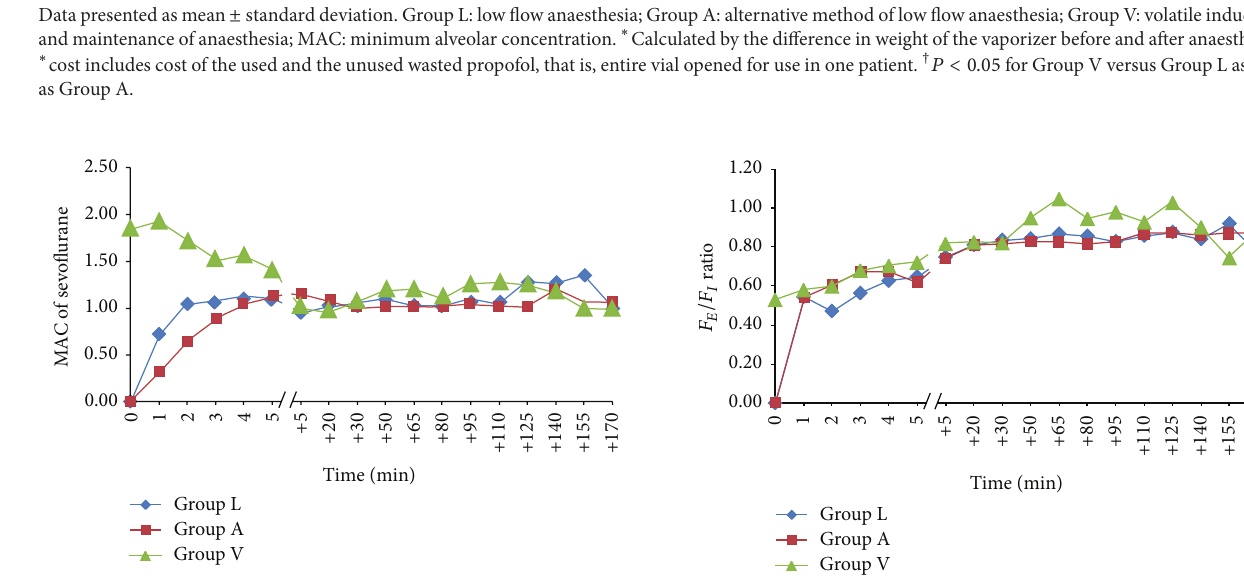
Figure 1: MAC of sevoflurane versus time. Group L: low flow anaesthesia, Group A: alternative method of low flow anaesthesia, and Group V: volatile induction and maintenance of anaesthesia.